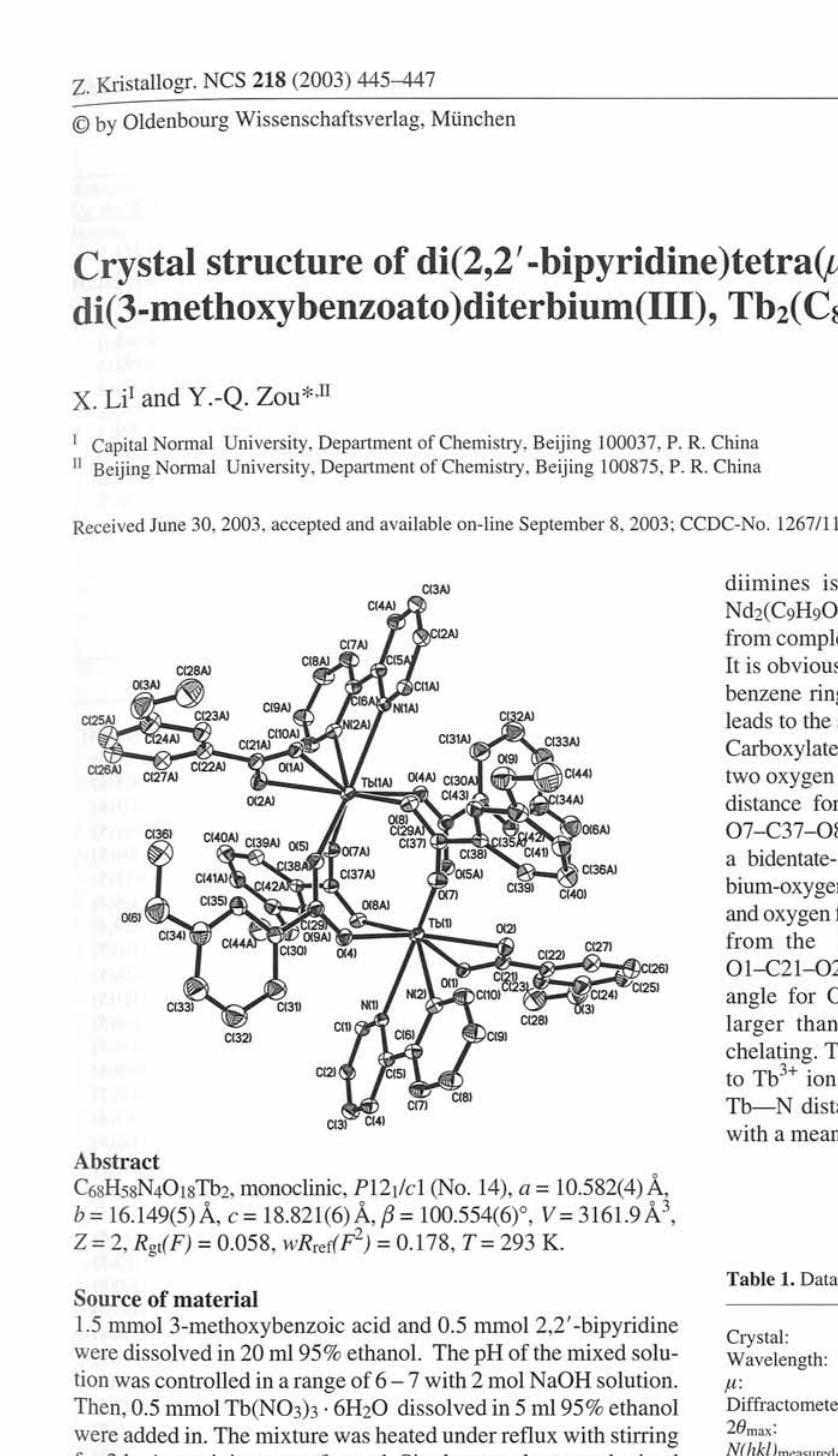
Table 1. Data collection and handling. Crystal: